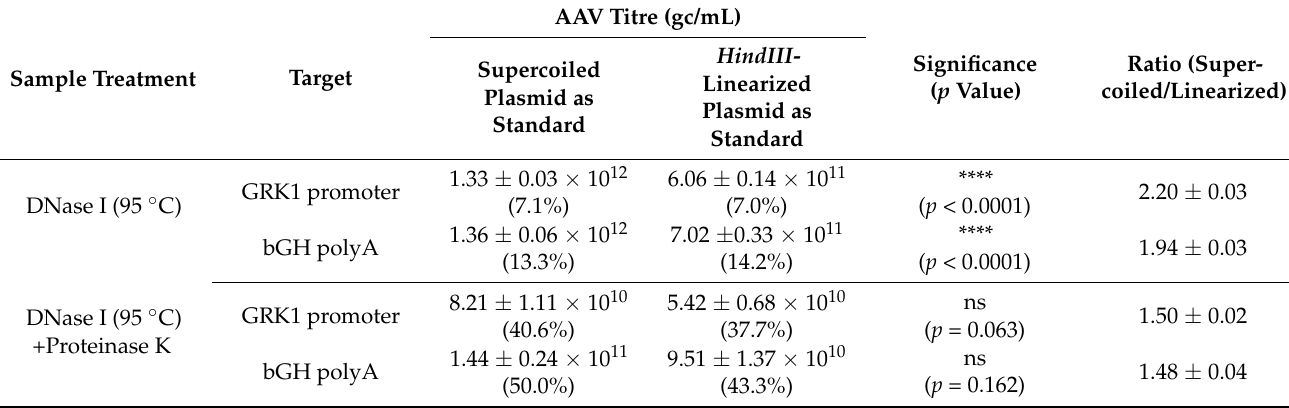
Values are the mean ± standard error of the mean. Values in parenthesis are the coefficients of variation. Statistically significant different titer values between calculations using supercoiled plasmid or HindIII -digested plasmid as standard are indicated (ns: not significant). The ratio indicates the absolute difference using supercoiled standard when compared to the HindIII -linearized plasmid (mean ± standard error of the